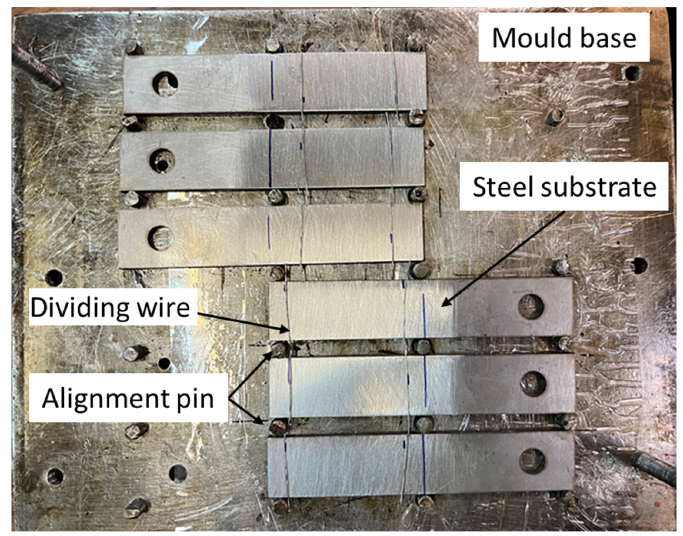
Figure 2. Mold used for the manufacturing of the SLJs.